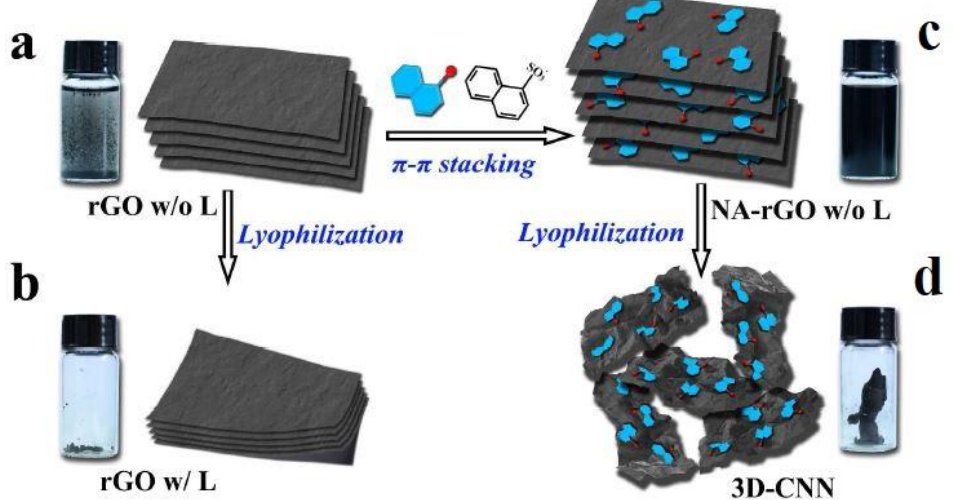
Figure 2. Schematic diagram of the fabrication process of 3D-crumpled NA-rGO nanosheets for NO 2 gas detection. ( a , b ) The formation of aggreated 2D plane rGO nanosheets with the